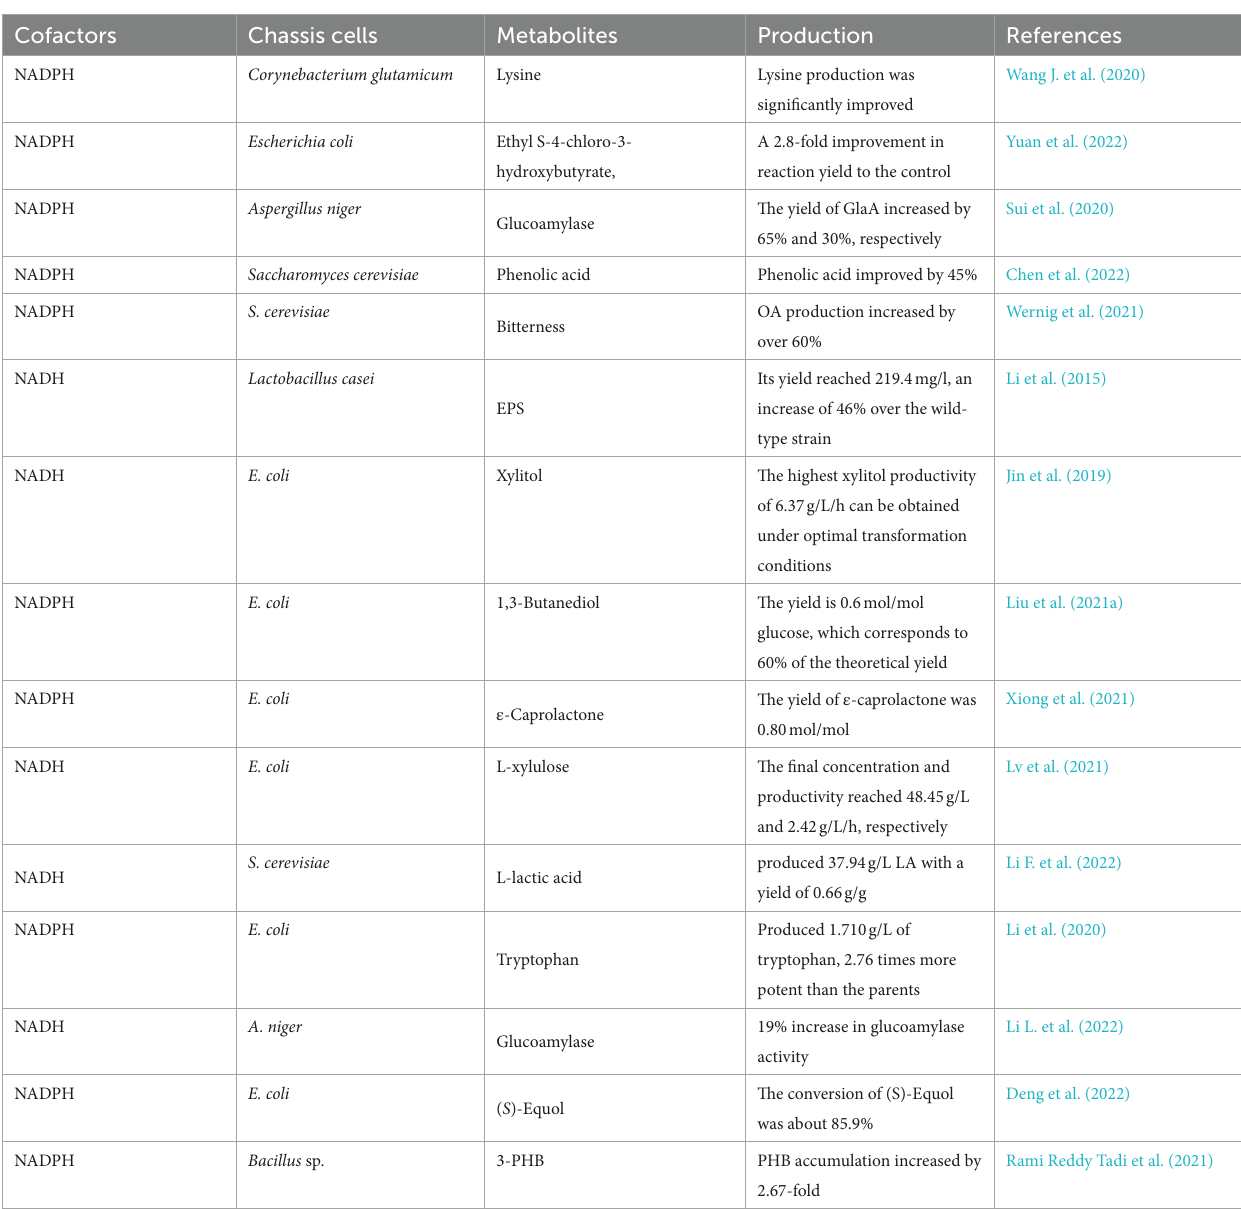
TABLE 2 NAD(P)H regulatory